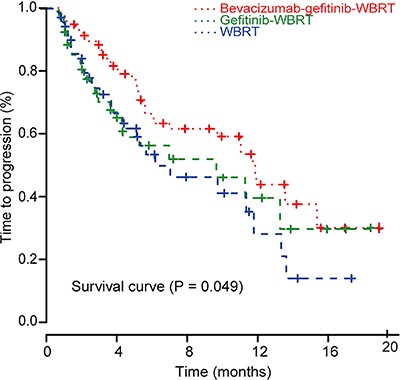
Kaplan-Meier estimation of progression-free survival in patients with brain metastases due to non-small-cell lung cancer treated with bevacizumab-gefitinib-WBRT, gefitinib-WBRT and WBRT. WBRT: whole brain radiotherapy.